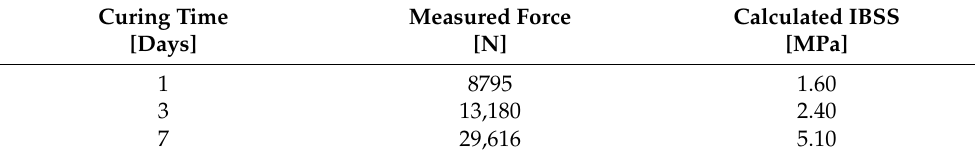
Table 3. IBSS for the cement samples cured at 1 day, 3 days and 7